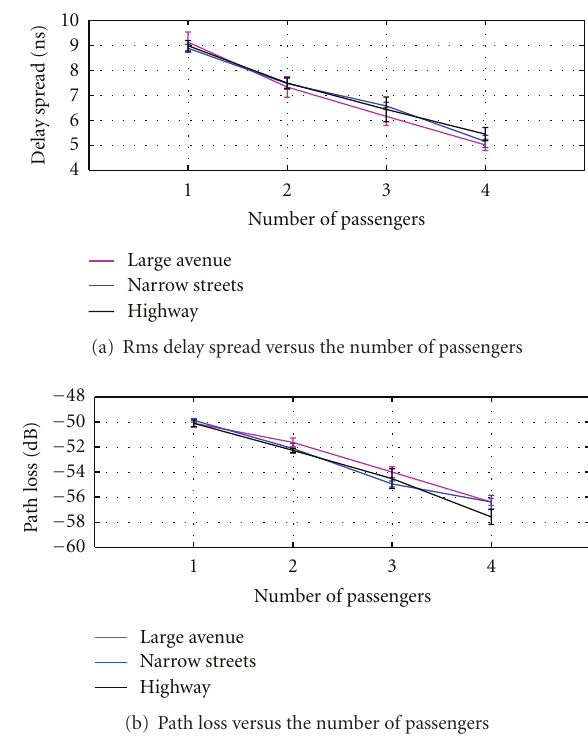
Figure 3: Rms delay spread (a) and path loss (b) in function of the number of passengers. For both parameters, values decrease with the number of passengers and are quite similar for all the